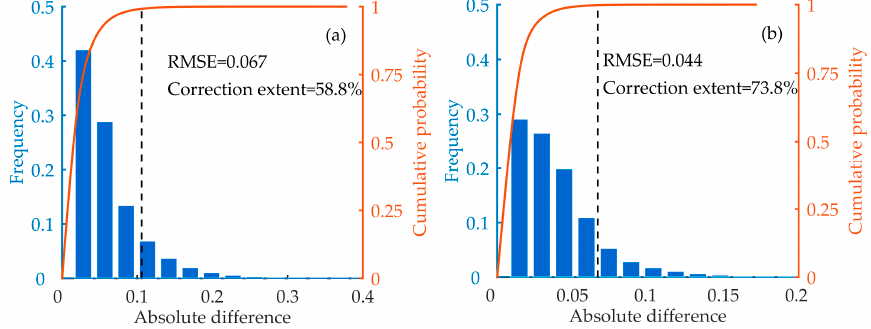
Figure 11. Influence of NDVI gradient on algorithm accuracy. ( a ) Based on the whole scene; ( b ) Based on pixels with low NDVI gradient which is lower than 0.01. Correction extent refers to the ratio of reduced value of RMSE after correction by our algorithm to the corresponding value before correction.